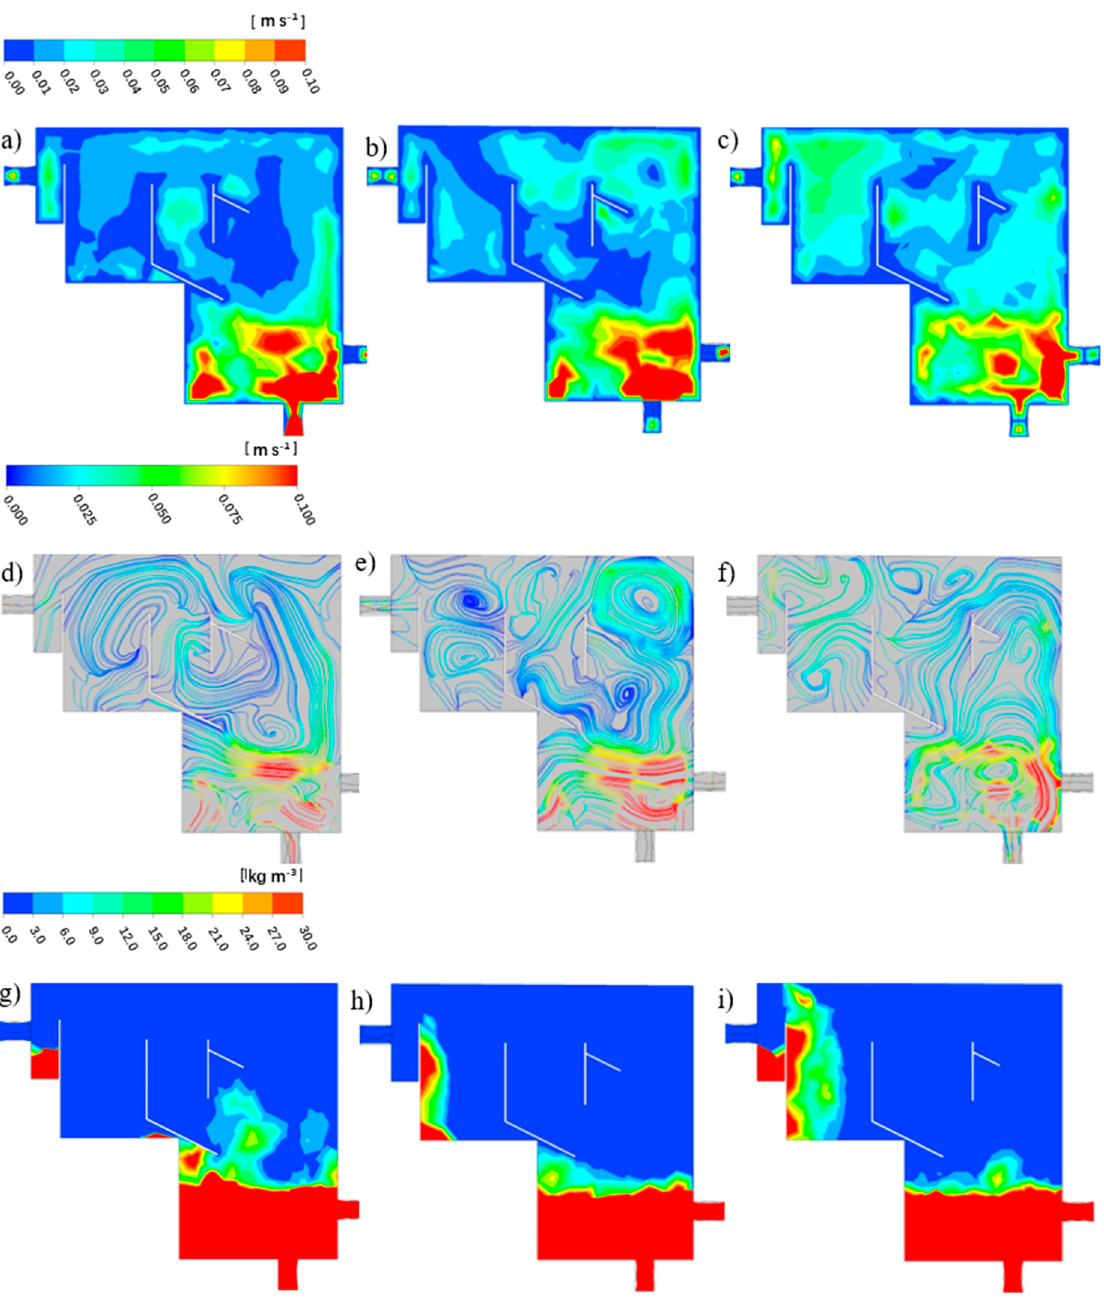
Figure 5. The water velocity contour plots, liquid velocity streamline and the particle distribution contour plots of the four types of R3 with the baffle distance of 30 mm ( a , d , g ),40 mm ( b , e , h ) and 50 mm ( c , f , i ).